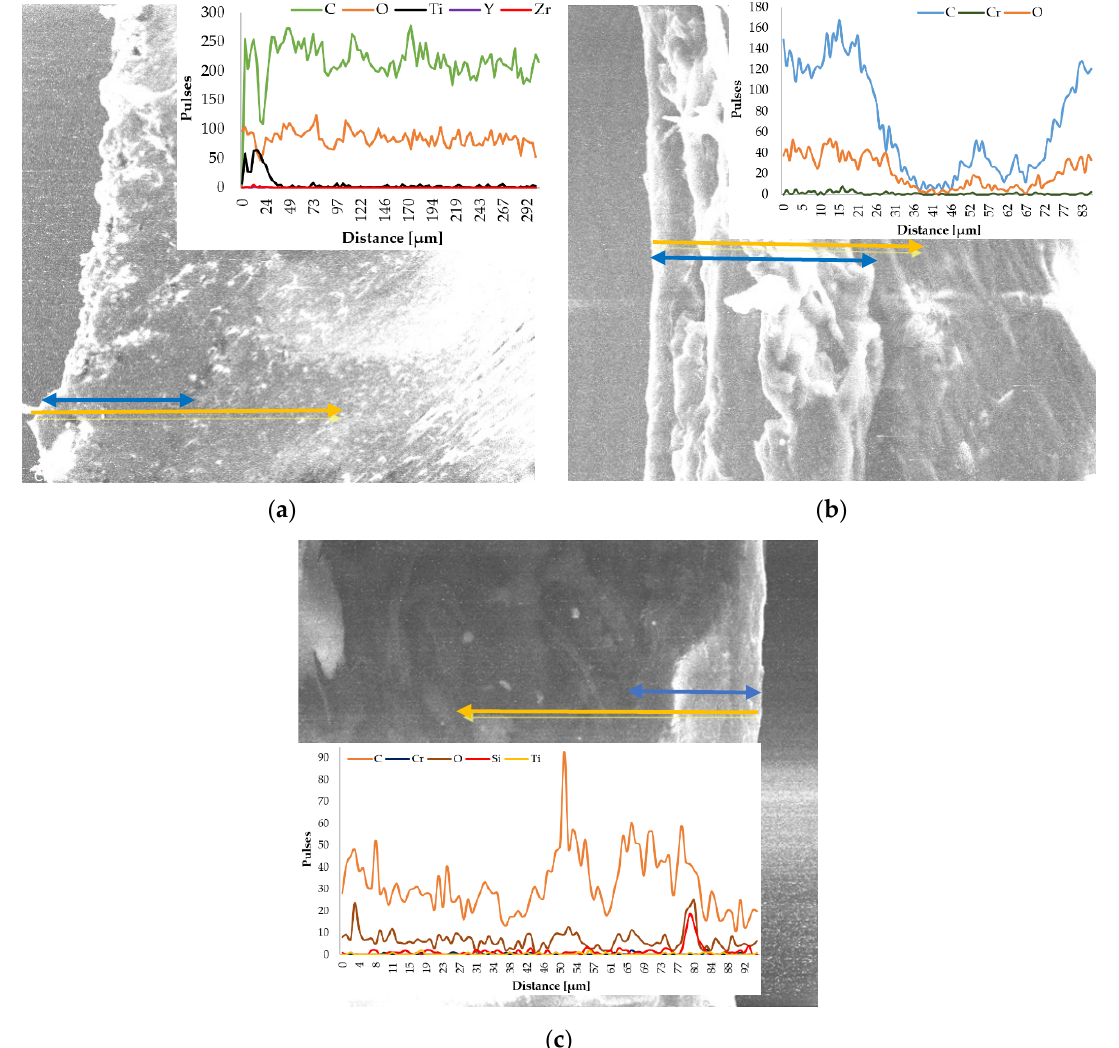
Figure 6. In line EDX analysis of the coated samples. ( a ) P3–143–9 passes, ( b ) P6–6420–9 passes, ( c ) P9–136–9 passes